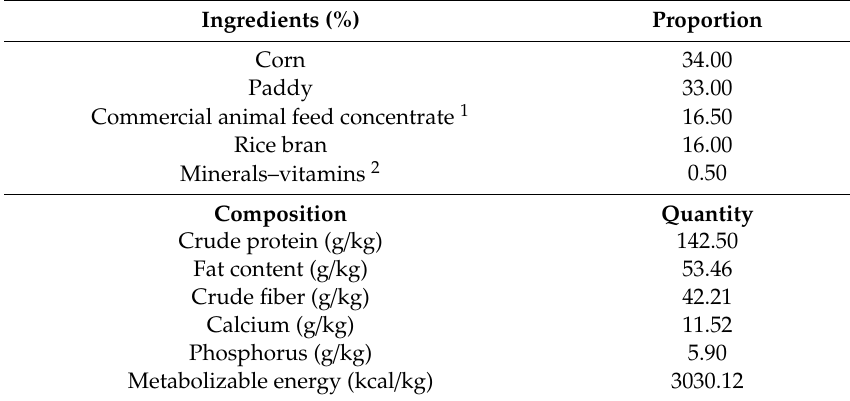
Table 3. Diet composition for laying